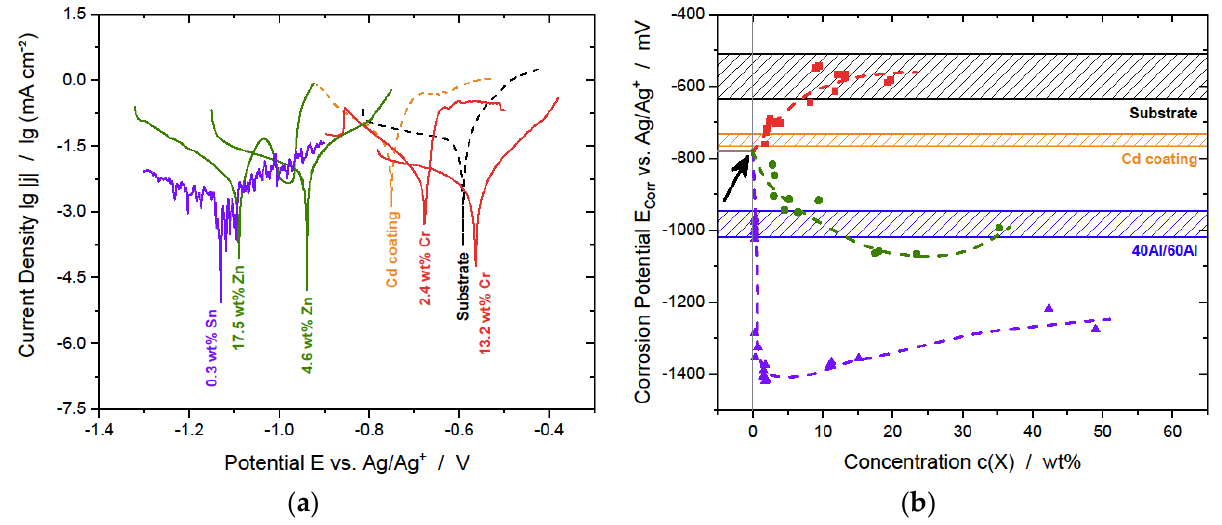
Figure 7. ( a ) Tafel plots of AlCr ( ▬ ), AlZn ( ▬ ), AlSn ( ▬ ) as well as Cd ( ▬ ) and steel substrate ( ▬ ) as reference (0.1 mV s −1 , 3.5 wt% NaCl, 25 °C) and ( b ) corrosion potential vs. concentration of Cr ( ■ ), Zn (●) and Sn ( ▲ ) in binary Al alloys and comparison to the corrosion potential of the steel substrate (black area), Cd (orange area) and sacrificial anode materials Al40 and Al60 (blue area). The dashed lines are just for eye-guidance and have no physical meaning. The black arrow marks the corrosion potential of the Al alloys for c(X) = 0.